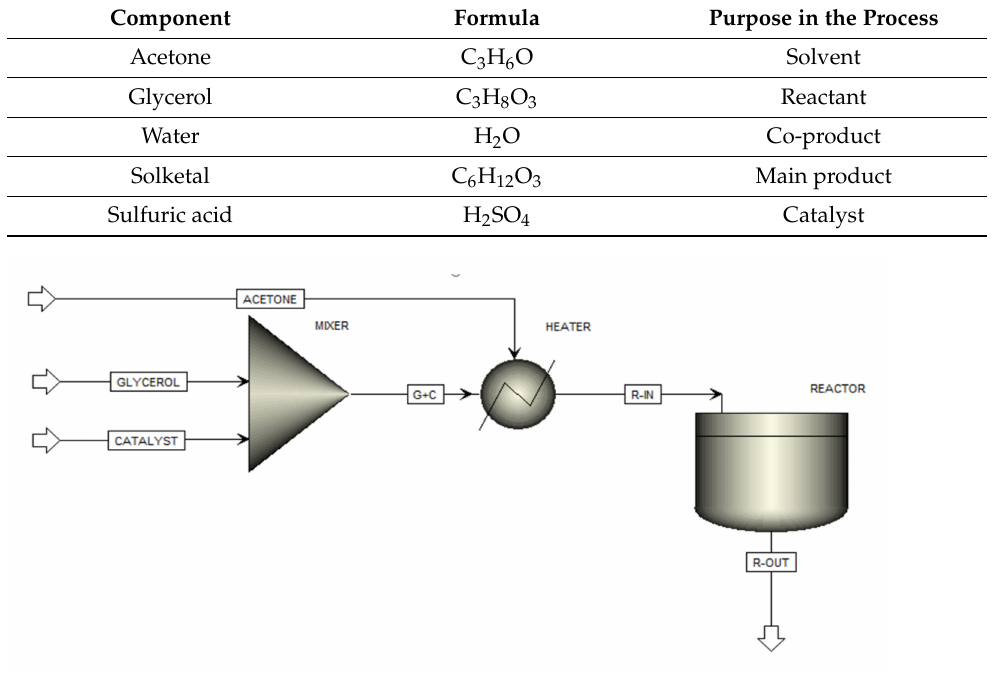
Figure 3. The simulation model developed for the ketalization of